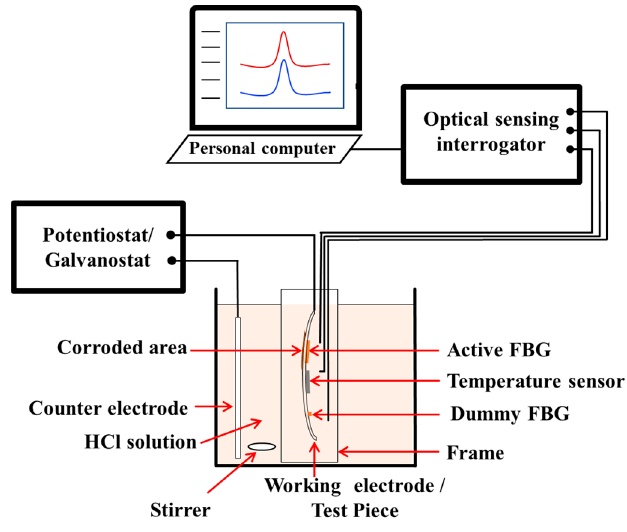
Figure 4. Set-up of galvanostatic electrolysis experiments to reduce thickness of the test piece.